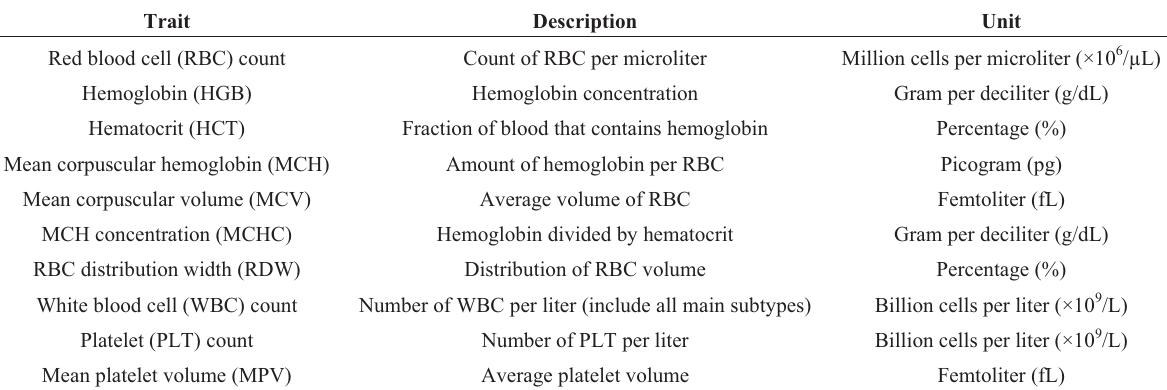
Table 1. Main blood cell traits routinely measured in standard complete blood count (CBC).